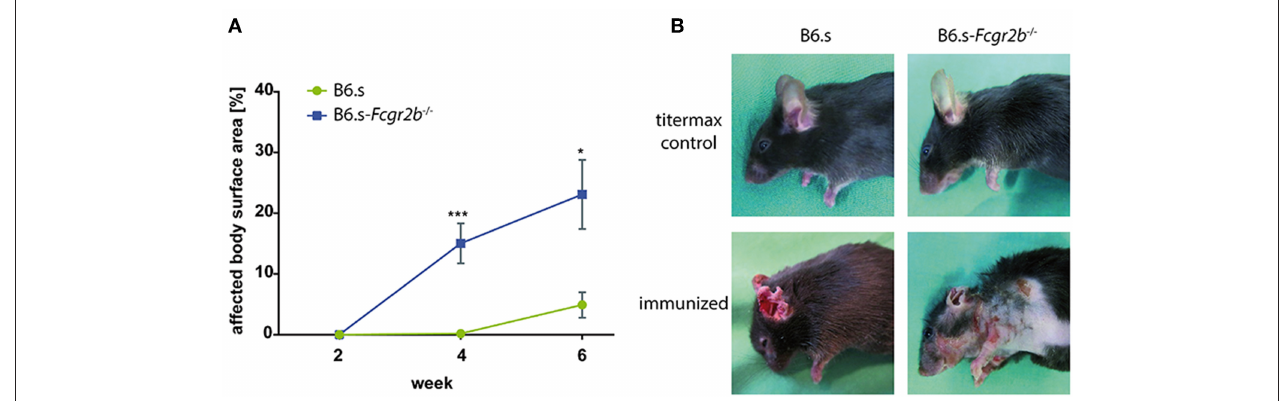
FIGURE 1 | Disease development in B6.s- Fcgr2b − / − mice compared to B6.s wt controls. vWFA2 was injected at a dose of 60 µ g/mouse s.c. into each of the hind footpads of B6.s mice ( n = 12) and B6.s- Fcgr2b − / − mice ( n = 12). Animals were monitored for 6 weeks. They developed erosions and crusts around the eyes, snout, ears, neck and torso. (A) Cumulative disease score of the affected body surface area between weeks 0 and 6 in B6.s- Fcgr2b − / − mice as compared with B6.s wt controls. Statistical differences between wt and Fcgr2b − / − mice were determined by an unpaired t -test. Values shown are the mean ± SEM; n = 12 for each group. (* p < 0.05; *** p < 0.001). (B) Representative pictures of non-immunized (upper row) and immunized (lower row, week 4) B6.s wt controls (left) and B6.s- Fcgr2b − / − mice (right).